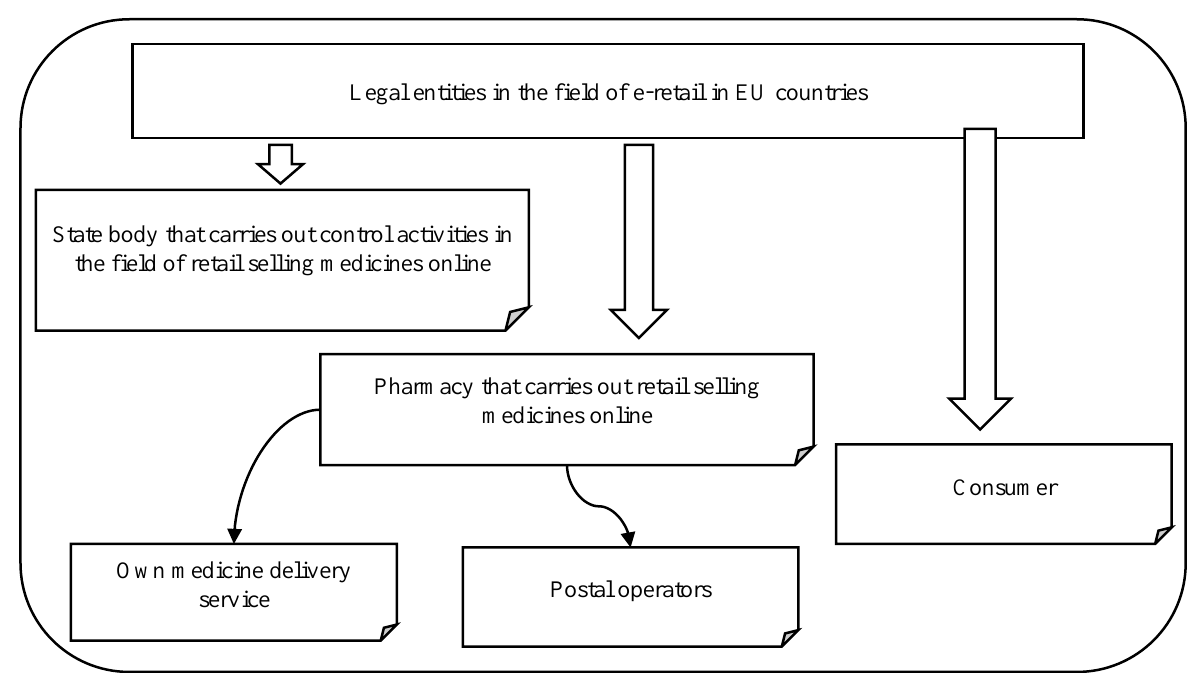
Fig. 1. Subjects of legal relations in the field of the online retail selling (distance selling) of medicines in accordance with Section VIII of EU Directive